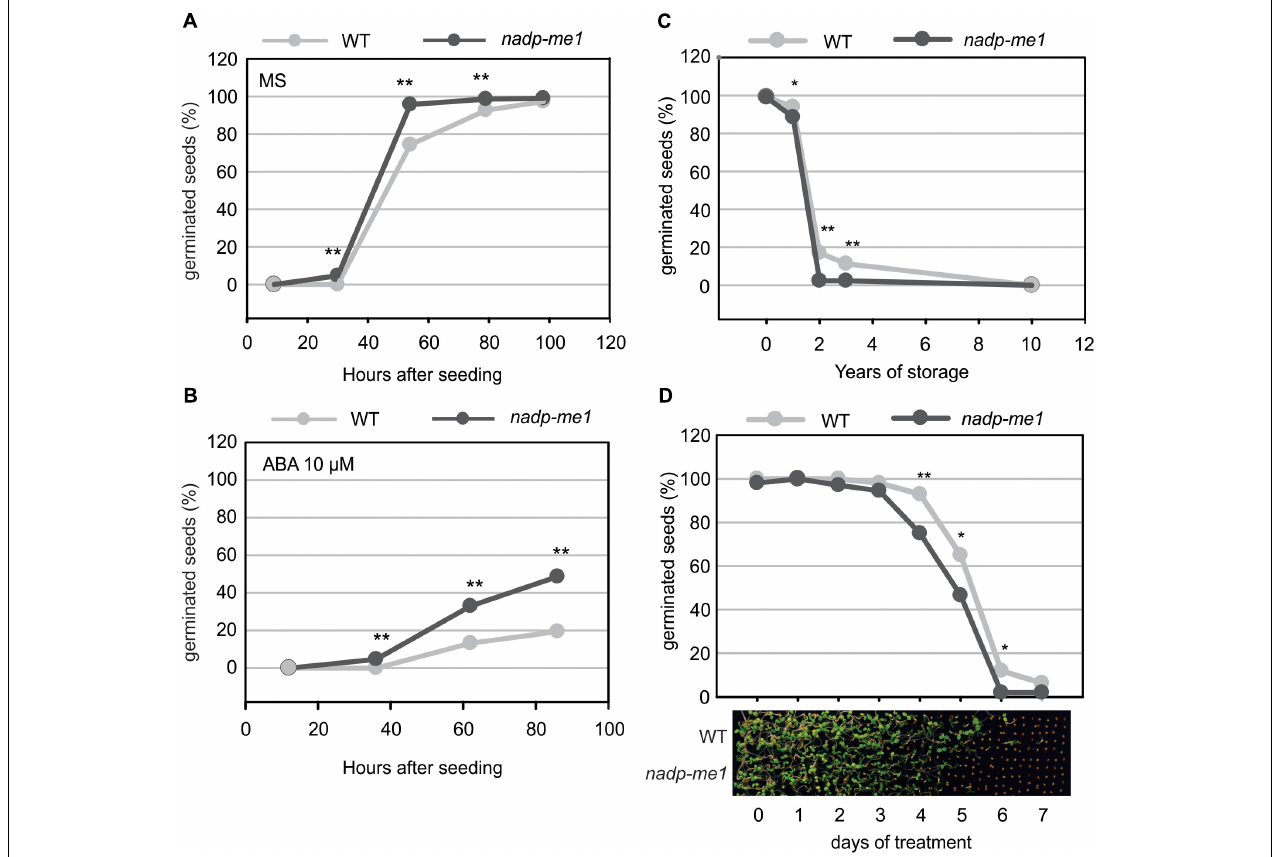
FIGURE 3 | Germination and seed viability assay in nadp-me1 mutant. Germination was evaluated by counting the number of seeds with visible radicles in MS plates (A) or MS supplemented with 10 µ M ABA (B) . Germination was also evaluated using long time stored seeds (C) or after exposing them to high temperature (40 ◦ C) for 1–7 days (D) . The proportion of germinated seeds after evaluating 300 seeds per line in each case is shown. One or two asterisks denote significant differences of p < 0.05 or p < 0.001, respectively, between WT and nadp-me1 according to the analysis of proportions of germinated seed ( z -test) in each line at each time point.